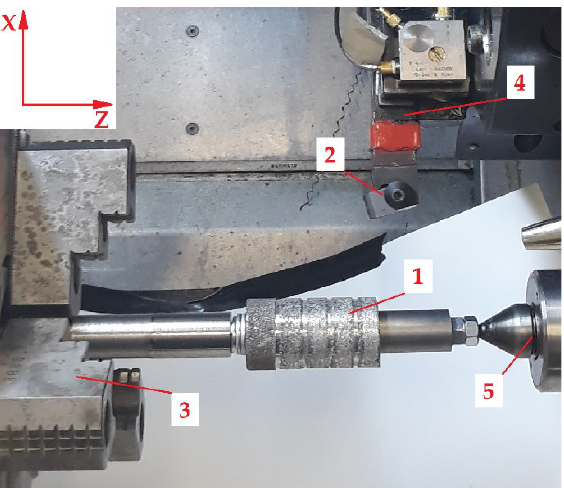
1—sample shaft, 2—cutting insert, 3—chucks, 4—dynamometer, 5—tailstock.